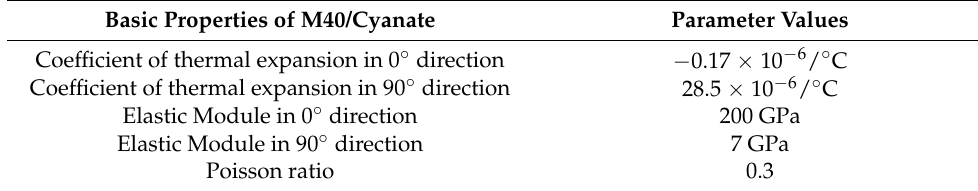
Table 1. Mechanical parameters of M40/cyanate.